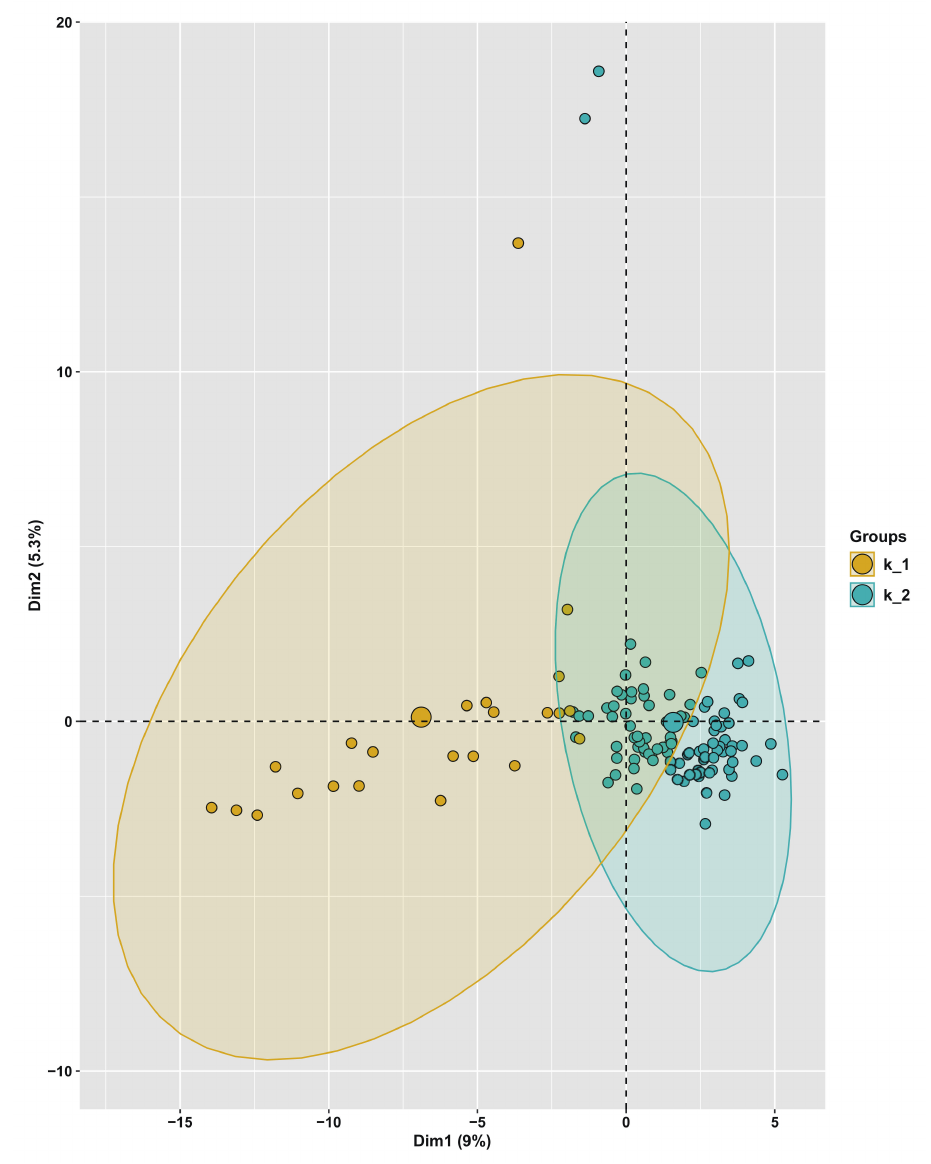
Figure 3. Principal component analysis of 171 turnip germplasm varieties based on SSR markers. All varieties were aggregated into two groups, k_1 and k_2, matched to the population